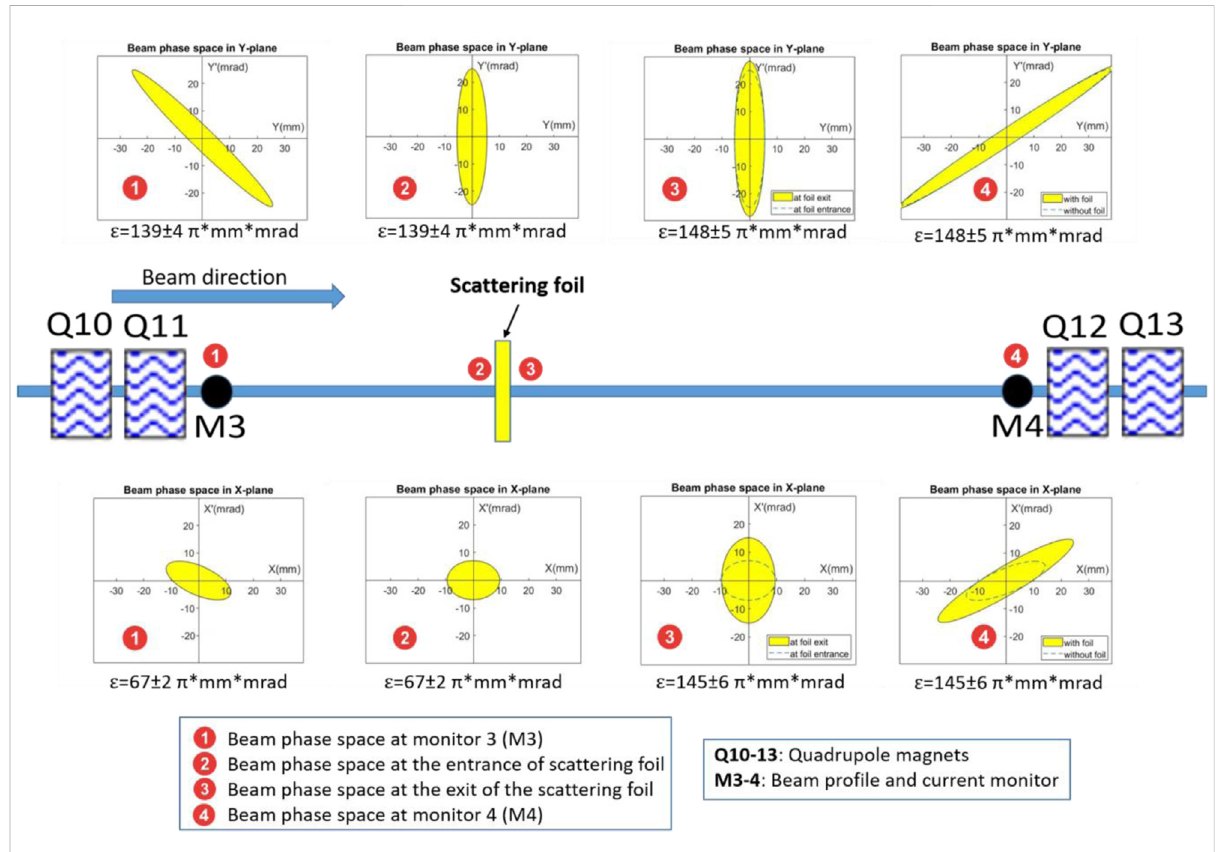
FIGURE 3 Phase space ellipses are shown at (1) 1 m before scattering foil at monitor M3, (2) at the entrance of the scattering foil, (3) at the exit of the scattering foil, and (4) 1.5 m after scattering foil at monitor M4. Transmission improvement with scattering foil.